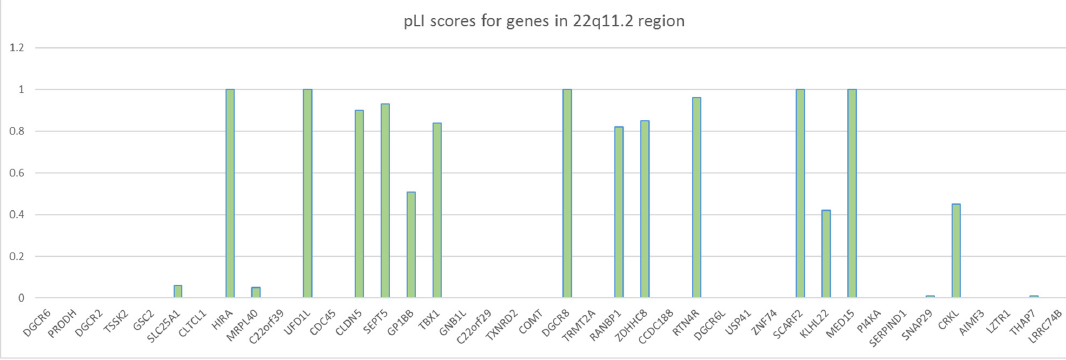
Figure 1. Scheme of the 22q11.2 microdeletion locus [4,7,18,33]. * Pseudogenes and undefined transcripts are not included in the figure.